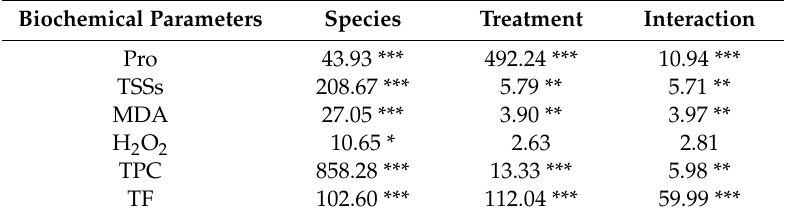
parameters measured: Biochemical Parameters Species